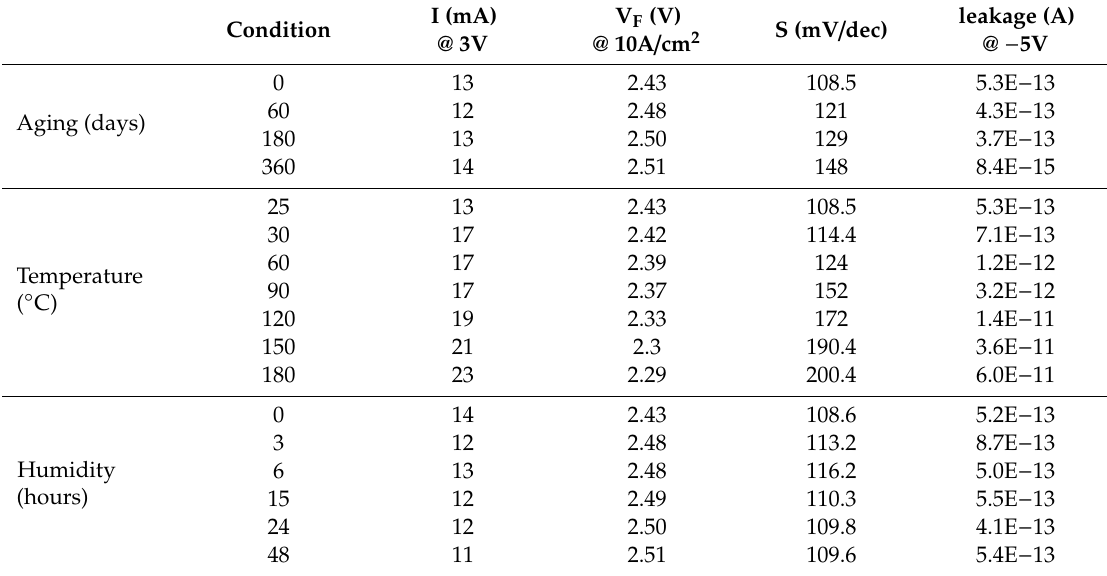
Table 1. Reliability test results of micro-LED devices under different conditions.